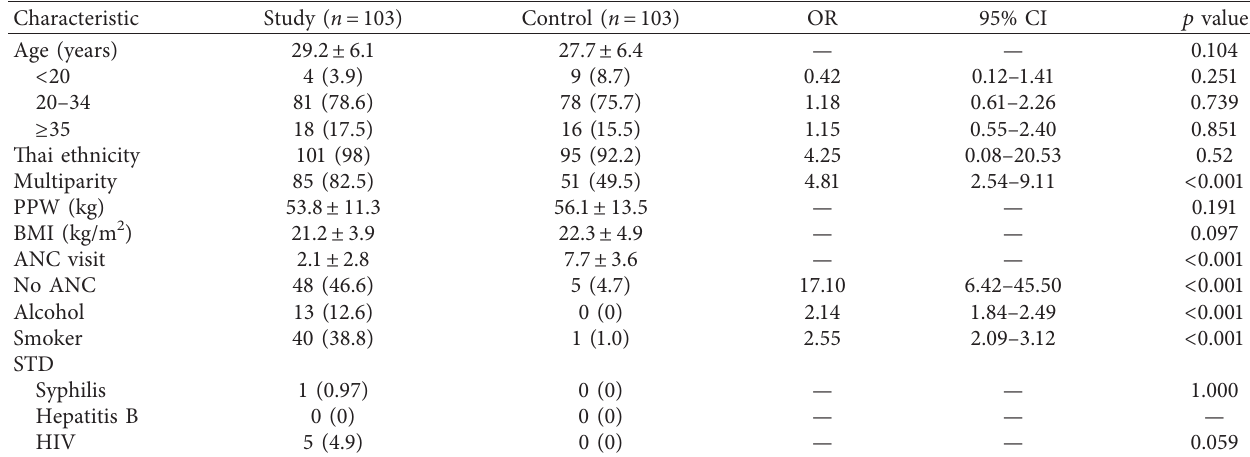
Figure 2: Flow chart of the study and control Table 1: Comparison of characteristic features between the study group and control group.